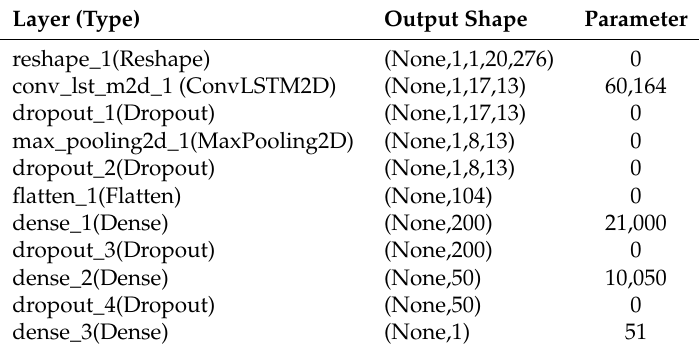
Table 1. Parameters of each layer of the LRCN architecture.